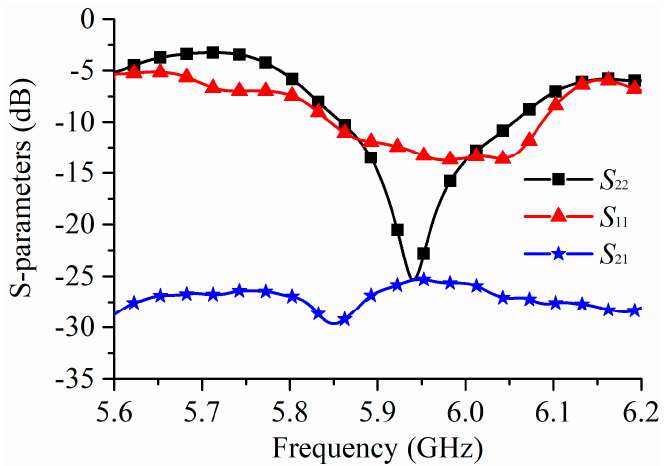
Figure 11. Measurement S -parameters of the proposed dual-polarized antenna.